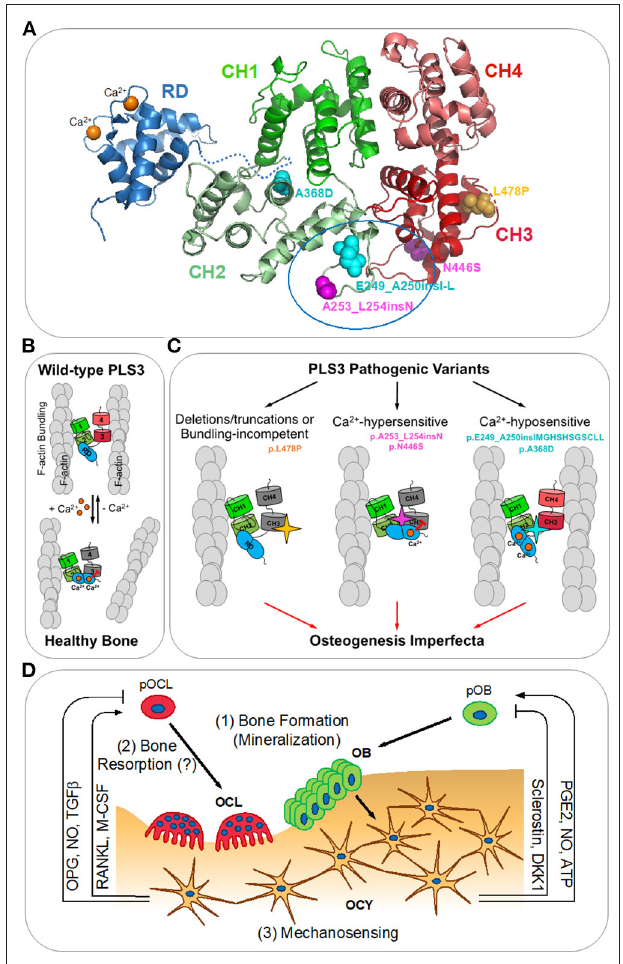
FIGURE 1 | PLS3 in osteogenesis imperfecta. (A) A homology model of human PLS3 built using Phyre2.0 ( Kelley et al., 2015) is colored according to the domain organization. Calponin-homology domains 1-2 (CH1 and CH2) and 3-4 (CH3 and CH4) form actin-binding domains 1 and 2 (ABD1 and